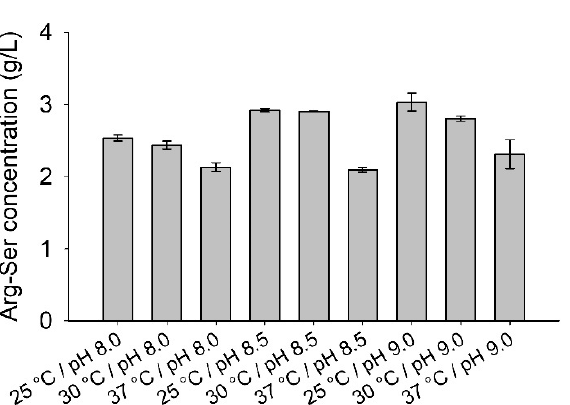
Figure 5. Effect of temperature and buffer pH on Arg-Ser production. Reactions were set up in du- plicate; data are presented as mean with error bars representing range.